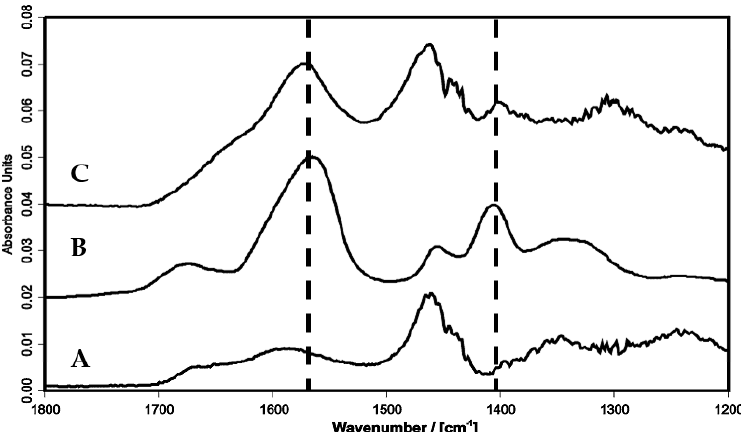
Figure 9. Ex situ ATR-FTIR spectra of dry solution cast PEL films: (A) Pure PEI from 0.015 M solution at pH = 10, (B) pure PAA from 0.015 M solution at pH = 10, (C) PEI from 0.015 M solution after circulating above PEM-20 of PEI / PAA. Broken lines indicate the ν a (COO − ) and ν s (COO − ) band of PAA carboxylate groups, which are absent in the pure PEI solution but present in the PAA solution (control) and PEI solution after circulating above PAA terminated PEM-20.